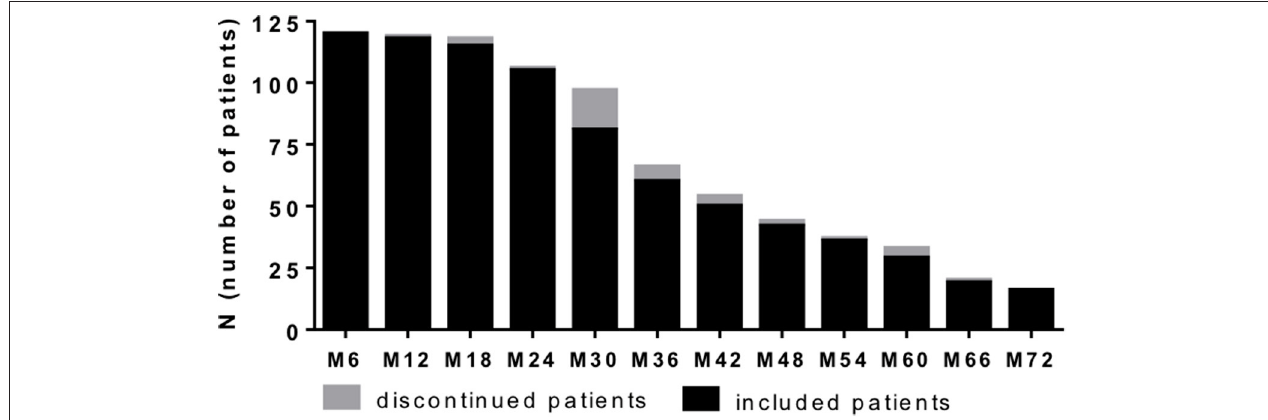
FIGURE 1 | Patient recruitment per 6 months period. One hundred and twenty patients with highly active MS were recruited and evaluated at data analysis. Based on consecutive sampling some of patients already reached 72 month follow up, whereas others did not yet at time point of data analysis. Number of patients included at defined time point are depicted (black bar). Additionally number of patients that discontinued NAT treatment at defined time point are presented (gray bar). Clinical and lab data were evaluated every 3 months.